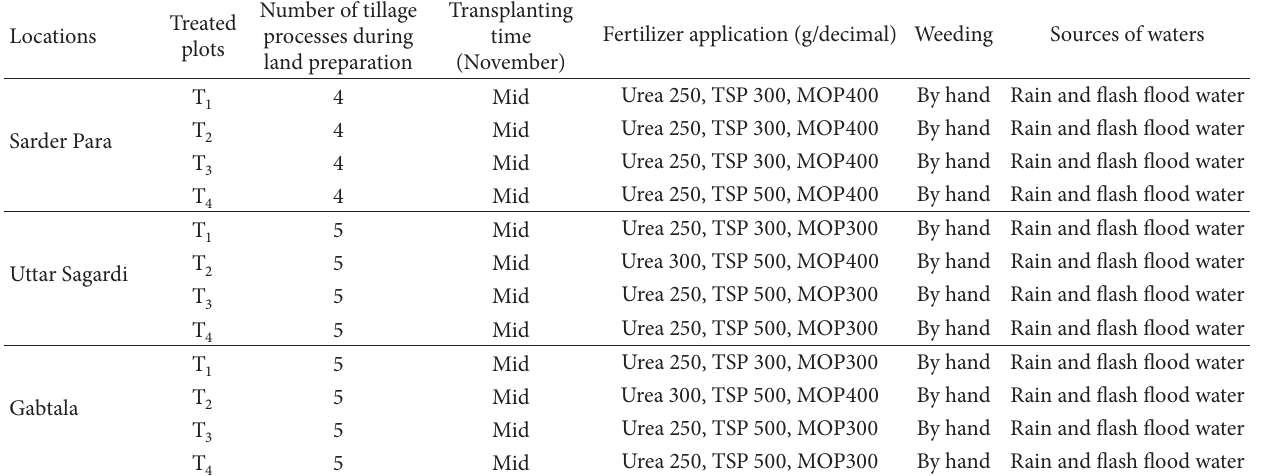
Table 2: Agronomic practices in each plot in the rice ecosystem in 2010-11.